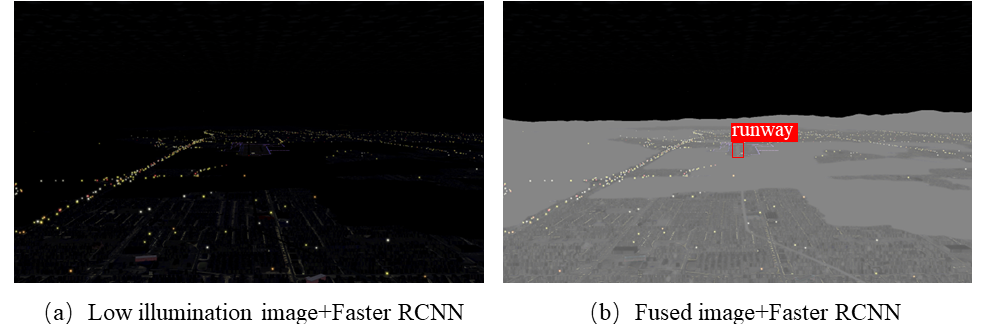
Figure 1. Detection comparison between the ( a ) low-light image and ( b ) enhanced image.